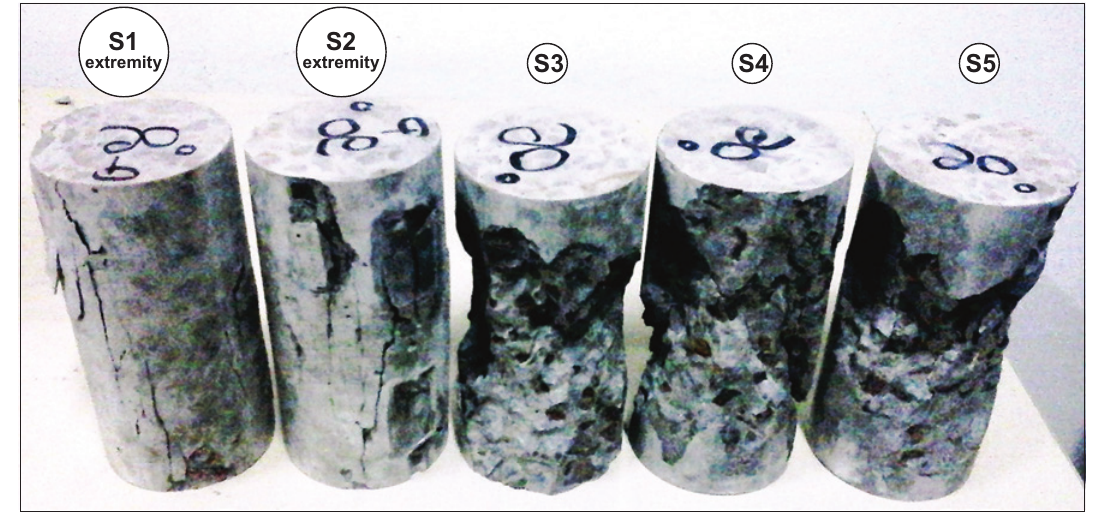
View of failure configurations of additional samples cast in horizontal position